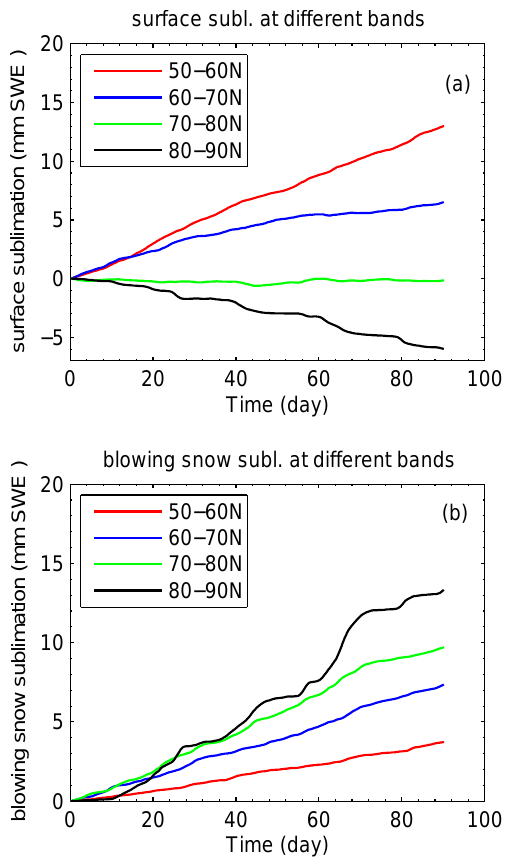
Fig. 11. Time evolution of surface sublimation (a) and blowing snow sublimation (b) averaged over latitudinal bands. Units in mm SWE.